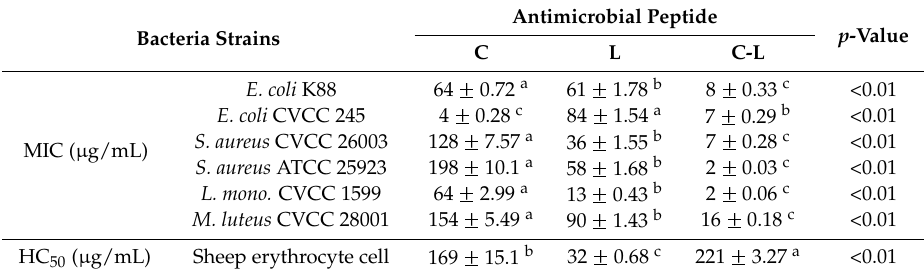
Table 3. The minimal inhibitory concentrations (MICs) and hemolytic activity (HC 50 ) of C-L, C, and L against six bacterial strains and sheep erythrocyte cell.